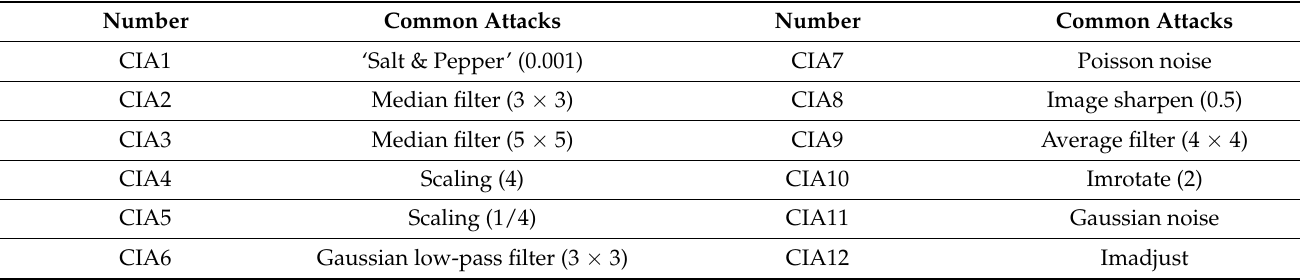
Table 3. List of common image processing attacks.